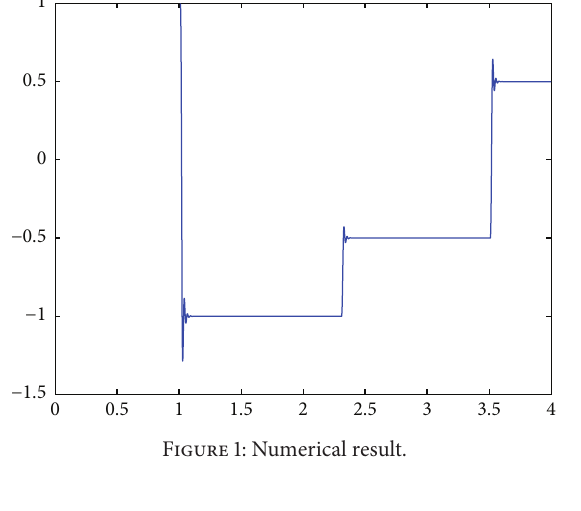
Figure 1: Numerical result. Figure 2: Exact solution.